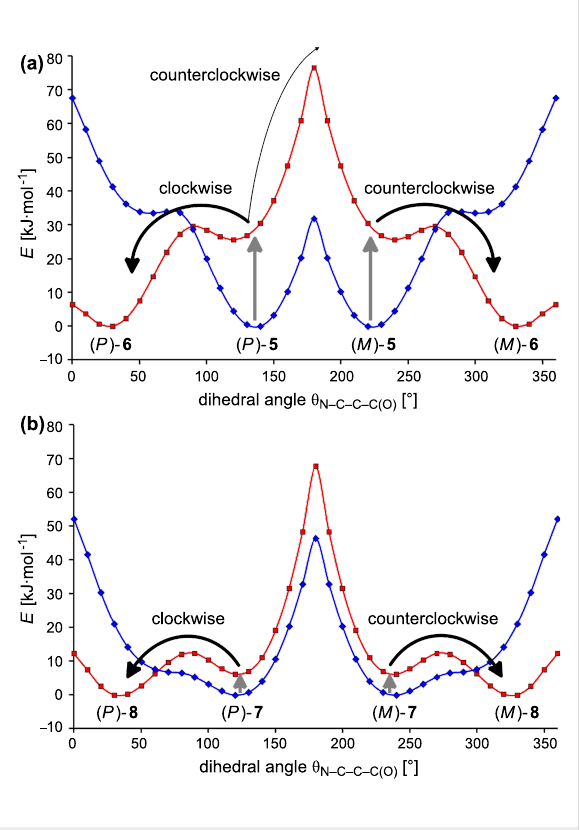
Figure 2: (a) Calculated energy profiles of the 3-methylpyridine deriva- tives 5 (blue) and 6 (red) in relation to the dihedral angles θ N–C–C–C(O) by use of B3LYP/6-31G*. (b) Calculated energy profiles of the 3-methylpyridine derivatives 7 (blue) and 8 (red) in relation to the dihe- dral angles θ N–C–C–C(O) by use of